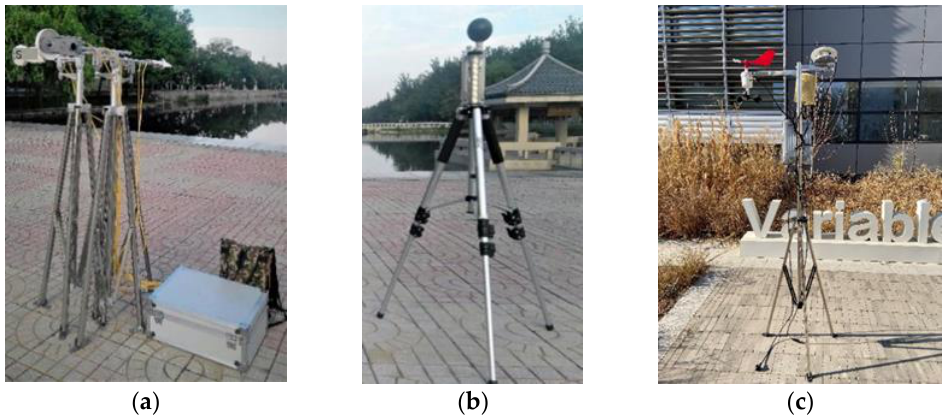
Figure 3. CNR4 net radiometer ( a ), global thermometer ( b ), and PC automatic weather station ( c ). Table 2. Instrumentation used for measurement of indoor physical parameters.